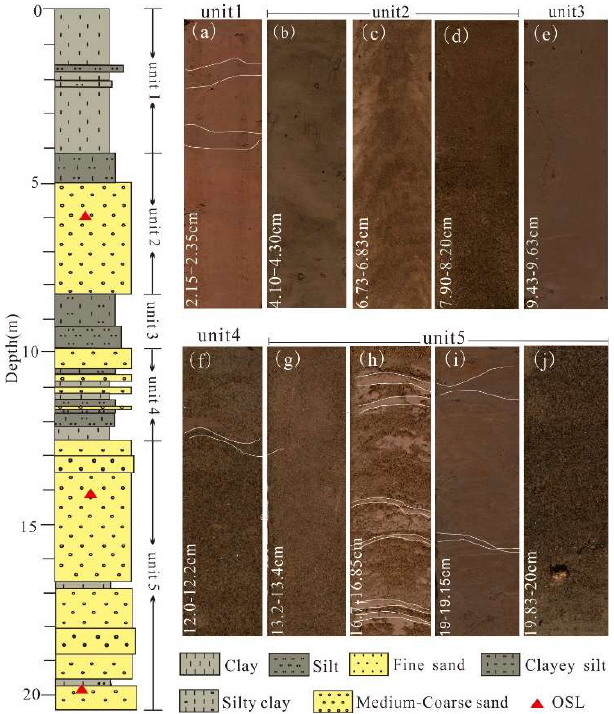
Figure 2. Sediment lithology and core photos. ( a ) Clay intercalated with thin-layer silt in unit 1. ( b ) The silt layer and fine sand layer in unit 2. Medium-coarse sand ( c ) and fining trend of sediments ( d ) in unit 2. ( e ) Silt layer of unit 3. ( f ) Medium-fine sand mix with small amount of clay (white line) in unit 4. ( g , h ) Fine sand intercalated with thin clay in unit 5. ( i ) Fine sand mixed with clayey silt in unit 5. ( j ) Medium-coarse sand layer in unit 5. “OSL” stands for optically stimulated luminescence dating. Unit 1: 0–4.0 m. This unit was predominantly composed of grayish yellow clay and clayey